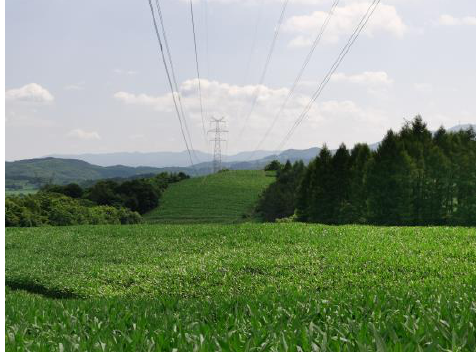
Figure 13. Live shooting of the test pictures.